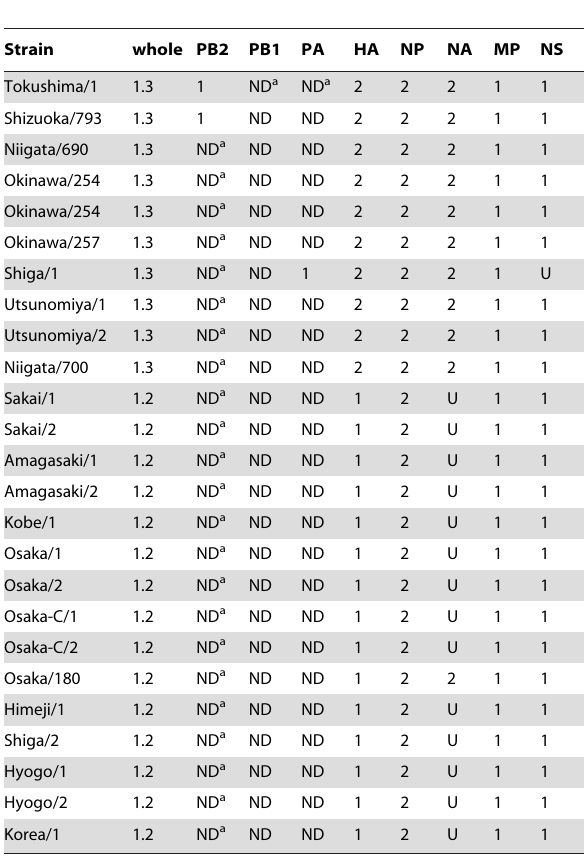
Table 3. Phylogenetically inferred cluster of each segment of the A(H1N1)pdm viruses in